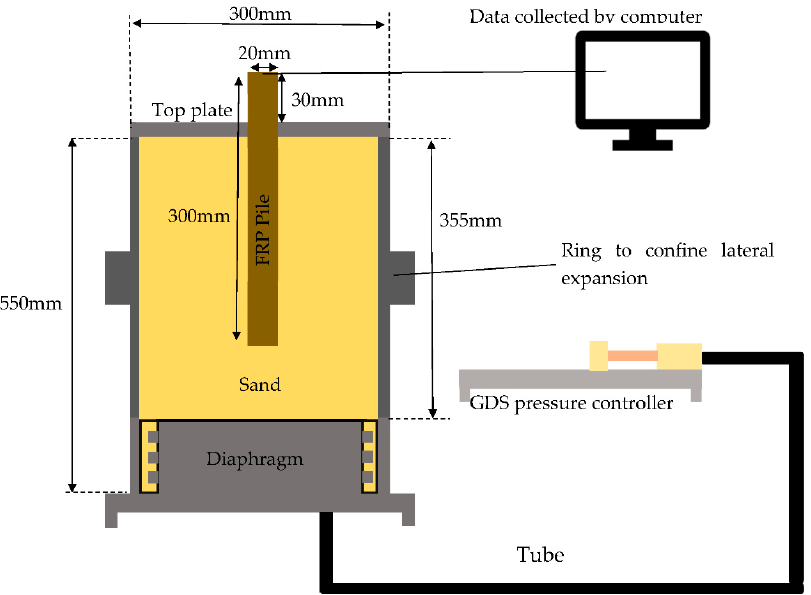
Figure 1. Illustration and dimensions of the setup tested in the laboratory connected to the GDS controller and computer (not to scale).